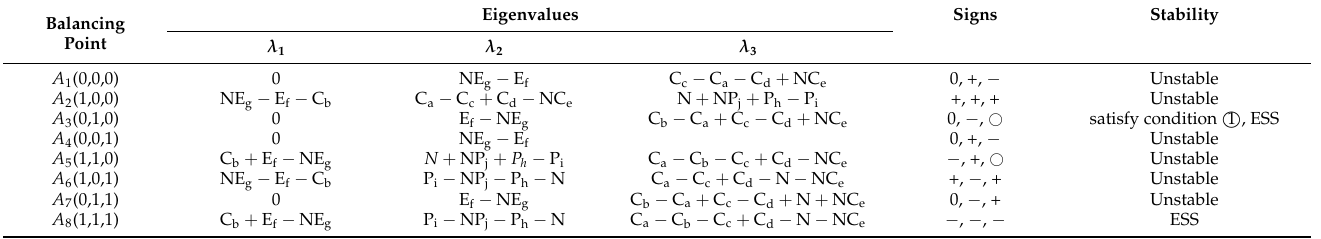
Table 5. Strategic Portfolio Stability Analysis under Miners, Government and SMEE Rational